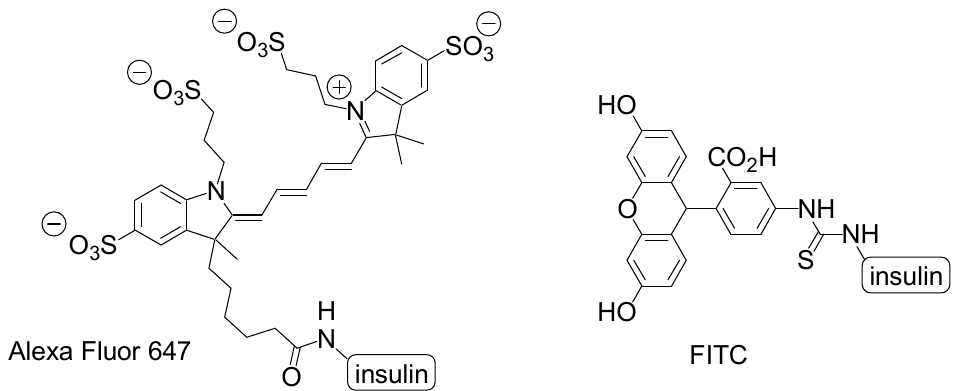
Figure 6. Structures of imaging dyes Alexa Fluor 647 and fluorescein isothiocyanate (FITC) introduced to the amino group of insulin.